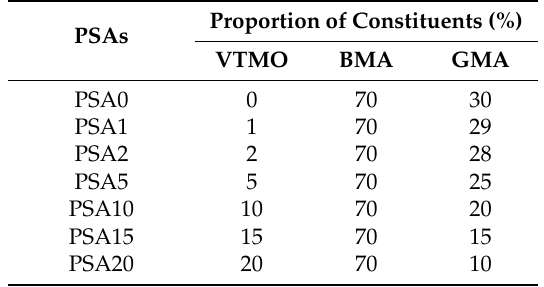
Table 1. Compositions of polymers of silicified acrylate copolymer with different monomers content.